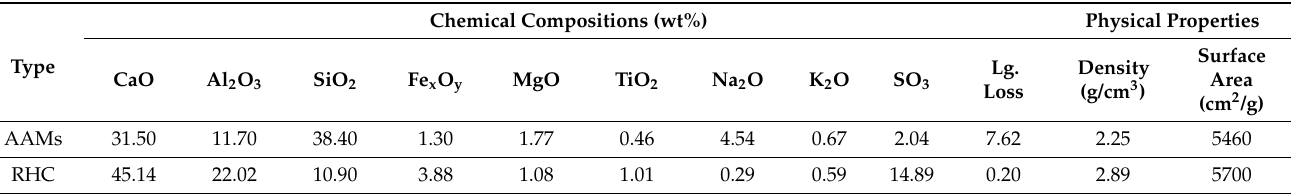
Table 1. Physical properties and chemical compositions of the powders used in binder jetting 3D printing (alkali-activated material (AAMs); rapid hardening cement (RHC)).